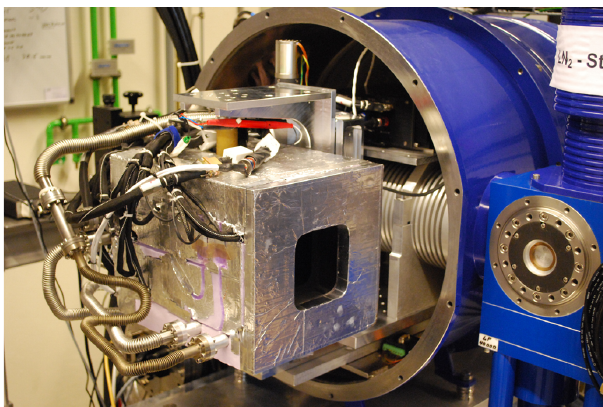
Fig. 6. View of the opened source chamber of the Reduced Background Calibration Facility. One of the GLORIA blackbodies is installed for calibration. To the right of the GLORIA blackbody, the reference blackbody VLTBB can be seen. Attached to the source chamber, the opto-mechanical unit with the liquid-nitrogen-cooled blackbody on top can partially be seen.